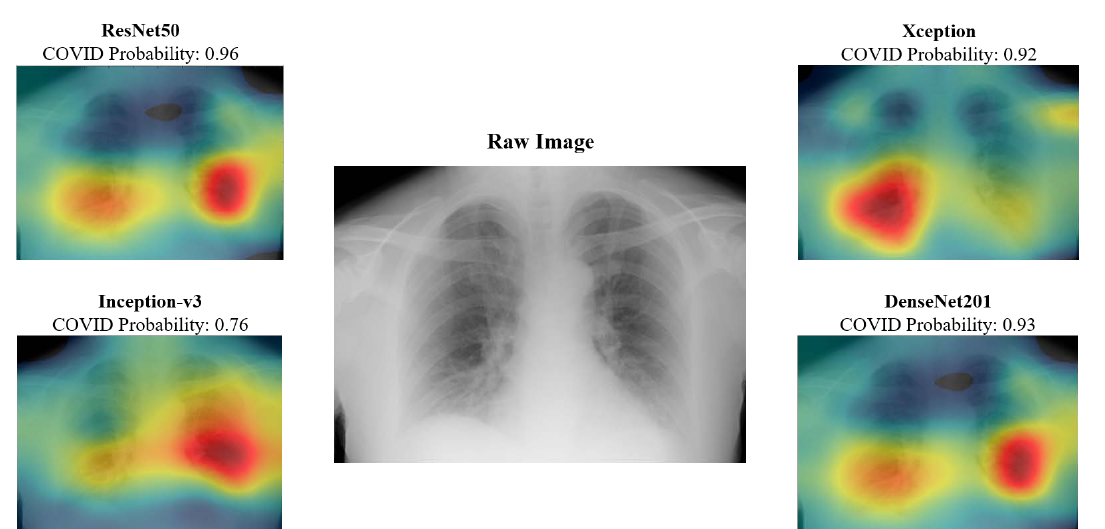
Figure 10. Class activation mapping results for a given test image using the proposed transfer-to-transfer learning approach for each network.